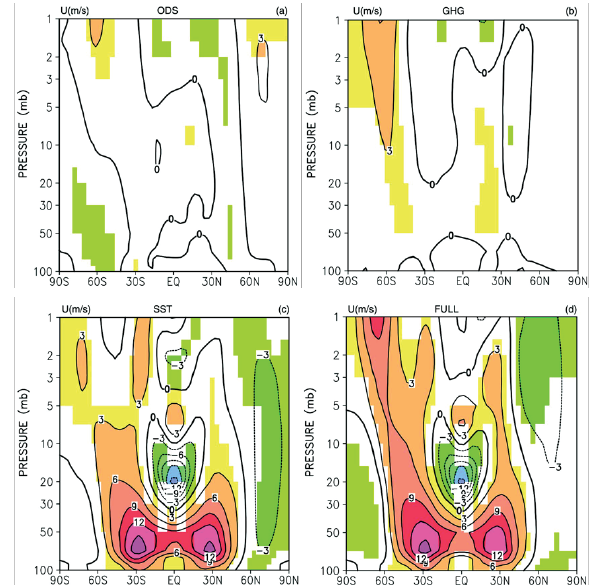
Fig. 2. Zonal, annual and ensemble mean changes of the zonal wind (ms − 1 ) from 2000 to 2100 caused by (a) ODS; (b) GHG; (c) SST/SI; (d) all factors (ODS, GHG, and SST/SI). Color pat- tern indicates the regions where the changes are judged statistically significant at or better than 5% level. Positive changes are shown in reddish colors while small or negative changes are colored in